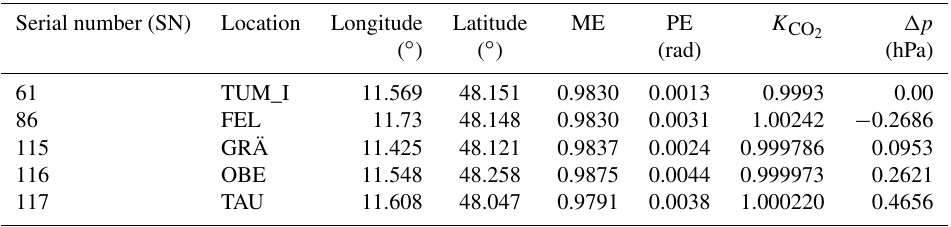
Table 1. Enclosure positions and EM27/SUN input parameters that are used for calibrating PROFFAST outputs of the five MUCCnet measurement sites (Frey and Gisi, 2021; Dietrich et al.,